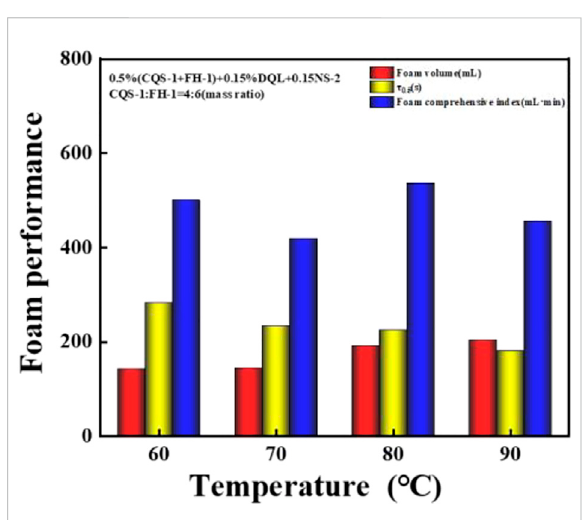
FIGURE 9 Effect of temperature changes on the foam performance of the CQS-1/FH-1 compounding